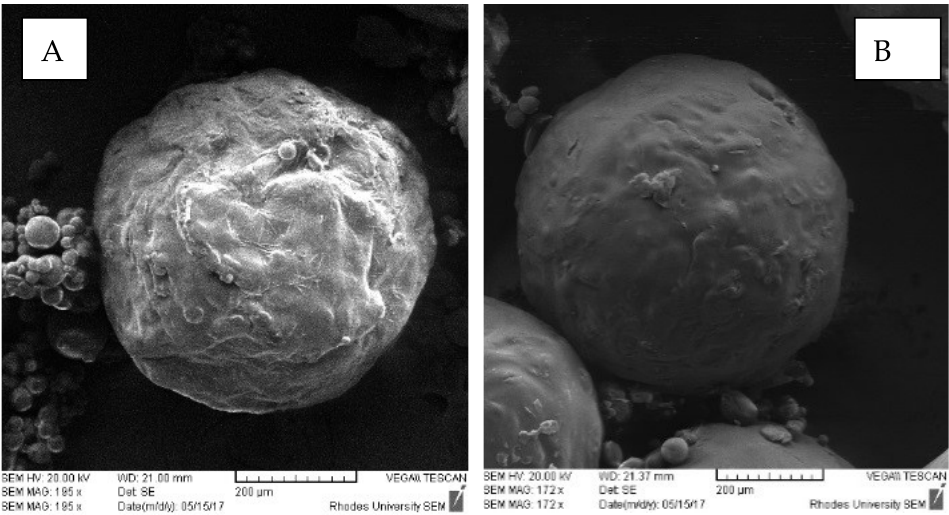
Figure 6. SEM images of INH-loaded microcapsules ( A ) batch INH-006 containing 3.00 g HPMC-AS and 1.00 g Eudragit ® L100 and ( B ) batch INH-007 containing 1.00 g HPMC-AS and 3.00 g Eudragit ® L100.